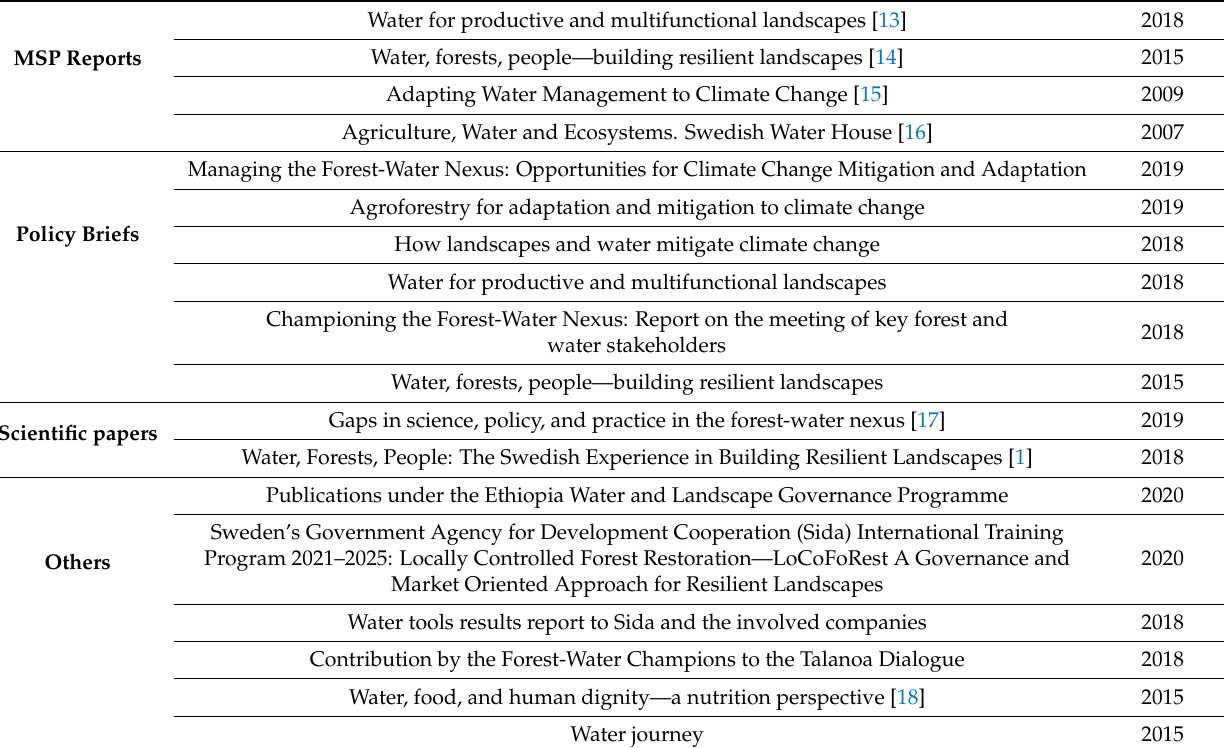
Figure 1. Establishing and sustaining multi-stakeholder learning dialogues and platforms (MSPs) over time related to the landscape theme (SIWI—Stockholm International Water Institute; SWH— Swedish Water House, WWW—World Water Week). Table 1. Publications and online tools produced by SWH MSPs.